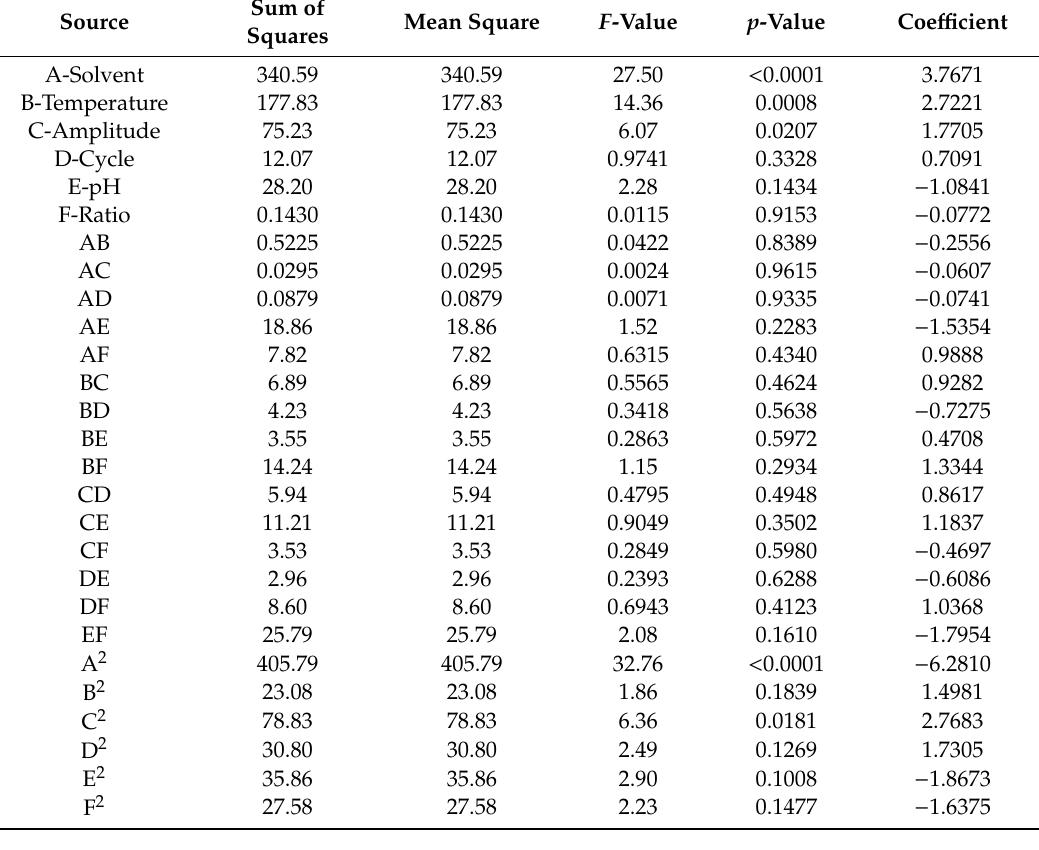
Table 1. Analysis of Variance (ANOVA) for the total phenolic compounds quadratic model.